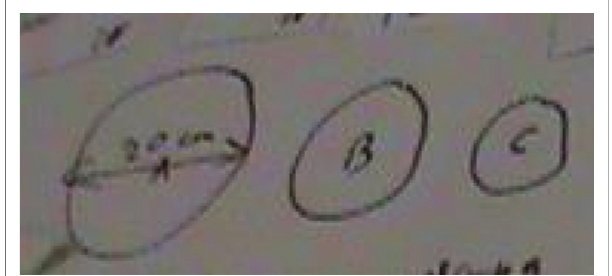
FIGURE 4: Learner D’s mathematical model for the three